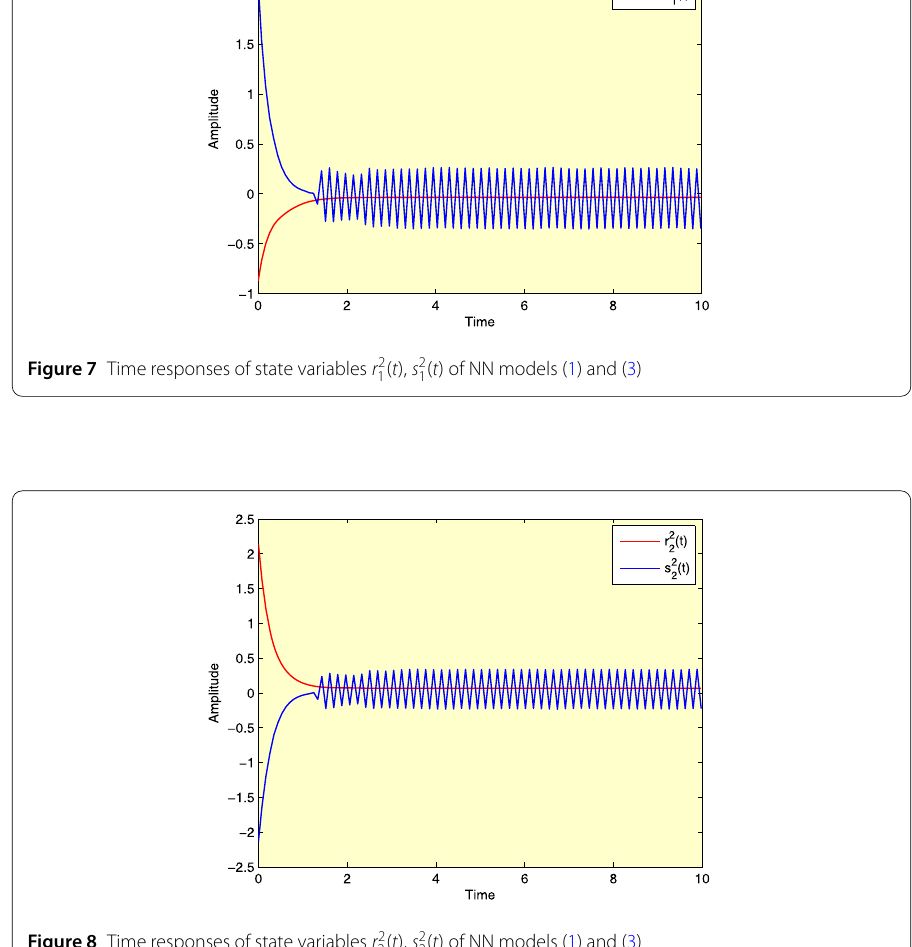
Figure 8 Time responses of state variables r 2 2 ( t ), s 2 2 ( t ) of NN models (1) and (3)